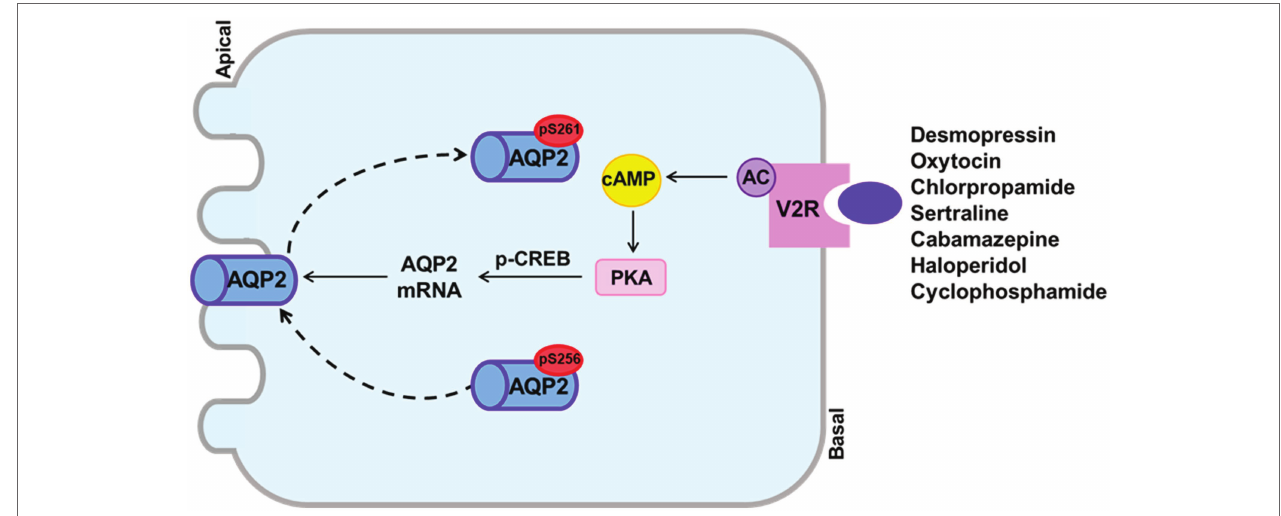
FIGURE 3 | The canonical pathway from the vasopressin V2 receptor (V2R) to aquaporin-2 (AQP2) upregulation to induce drug-induced hyponatremia. Drugs that can cause hyponatremia bind to the V2R at basolateral membranes of collecting ducts and stimulate adenylyl cyclase activity, resulting in increased cAMP production. The cAMP/PKA signaling also induces enhanced AQP2 targeting to the apical membrane and increased AQP2 transcription probably through CREB